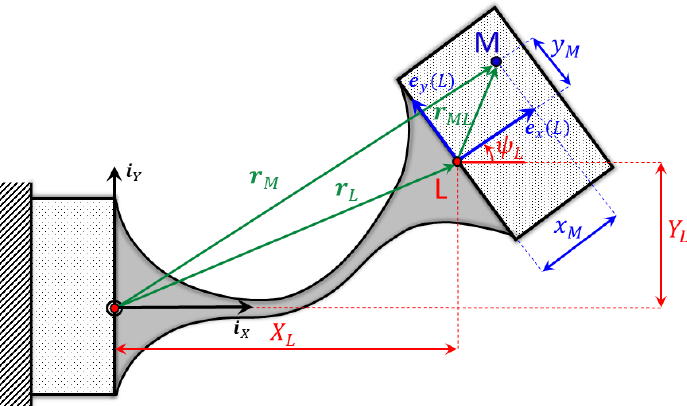
Figure 4. Generic configuration of two rigid bodies (fixed and mobile) connected by a flexure hinge. In other words, 𝑋 𝑀 ,𝑌 𝑀 are the coordinates of the generic point 𝑀 with respect to the global reference system, while 𝑥 𝑀 ,𝑦 𝑀 are the coordinates of the same point with respect to the mobile frame 𝒆 𝑥 (𝜓 𝐿 ),𝒆 𝑦 (𝜓 𝐿 ) , having its origin at the end of the flexure hinge. The coordinates of the centre of instantaneous rotation (c.i.r.) ( 𝑋 𝐶 ,𝑌 𝐶 , still unknown) of the mobile rigid body expressed in the global reference system do not change for an infinitesimal motion: